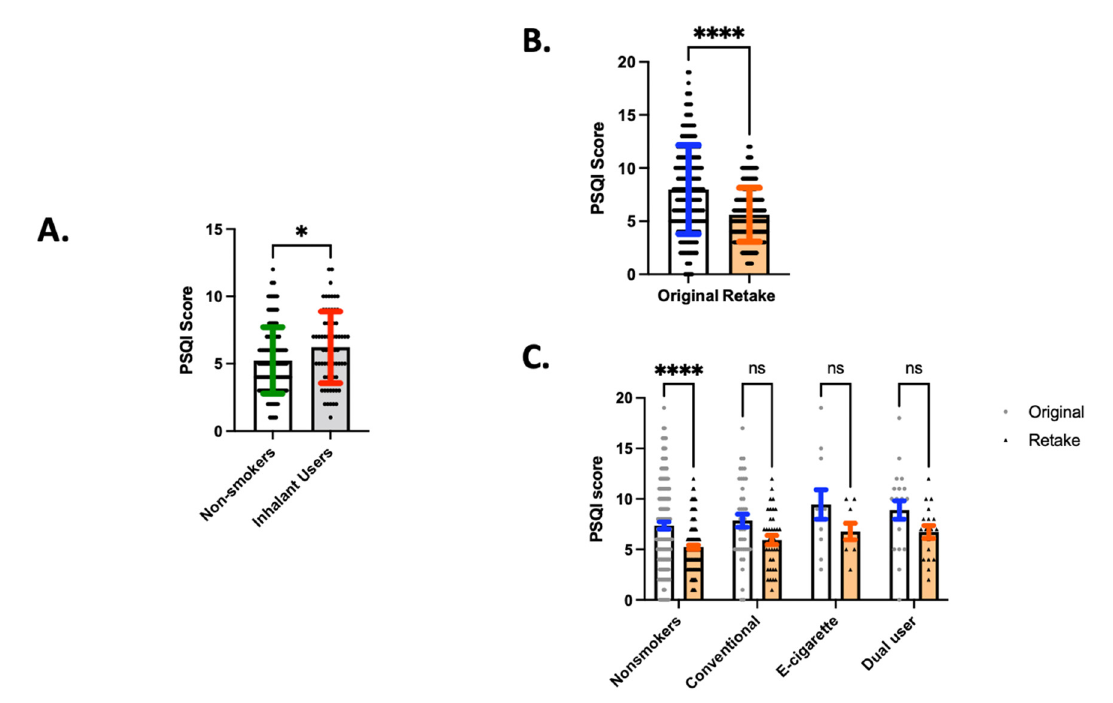
Figure 2. ( A ) Inhalant use associated with poorer sleep quality. Nonsmokers reported a lower PSQI score in the setting of the COVID pandemic relative to inhalant users, which comprises of e-cigarette users, conventional tobacco users, and dual users. ( B ) PSQI scores in the original survey, administered in April 2020, were higher than PSQI scores in the retake survey, administered in June 2020. ( C ) Nonsmokers had higher PSQI scores in June 2020 than in April 2020, whereas other inhalant groups had no significant change in PSQI scores during this time. * p < 0.05, **** p < 0.0001.